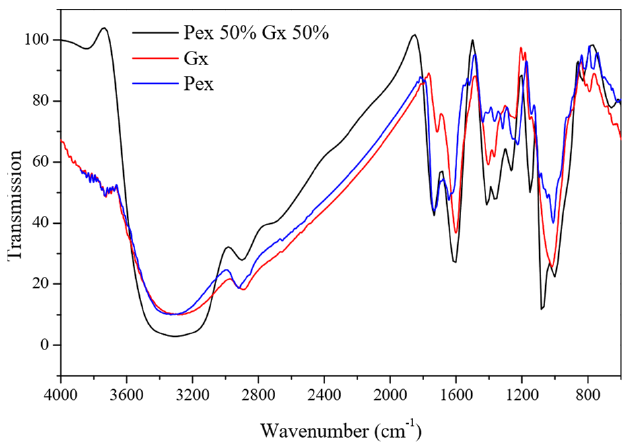
Figure 4. Infrared spectra of corrosion inhibitors: extracted pectin (Pex), xanthan gum (Gx), and the Pex 50%–Gx 50% mixture.